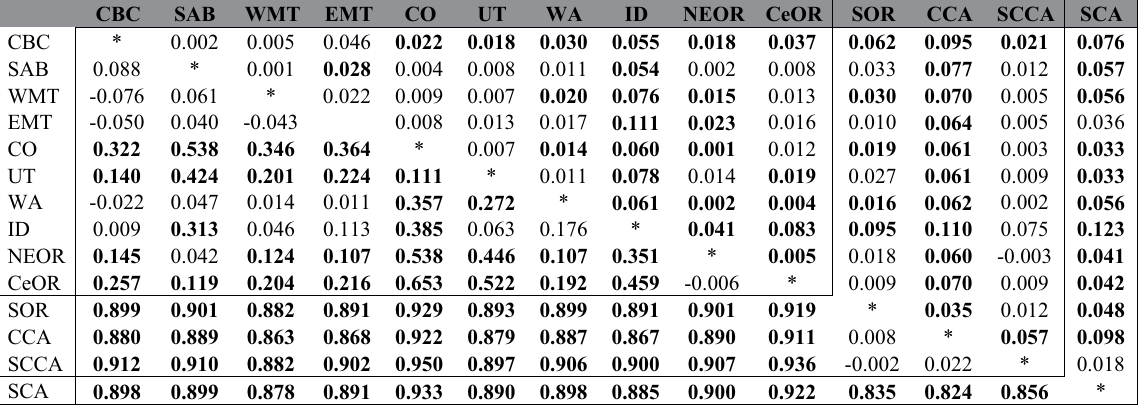
Table 2. MtDNA Φ ST (bottom left) and microsatellite F ST (upper right) values for pairwise comparisons among mountain chickadee populations (bold = significant after Benjamini-Hochberg correction). AZ, NWBC, BCR populations were excluded due to small sample size (n <